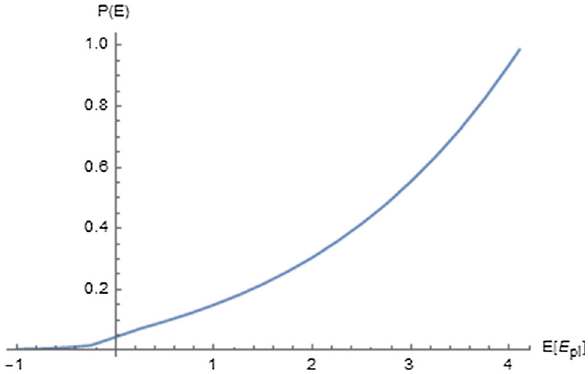
Fig. 3 The figure shows the energy dependence of the probability. As expected for a tunnelling process in a potential (32) ( P ( E ) → 1 , E